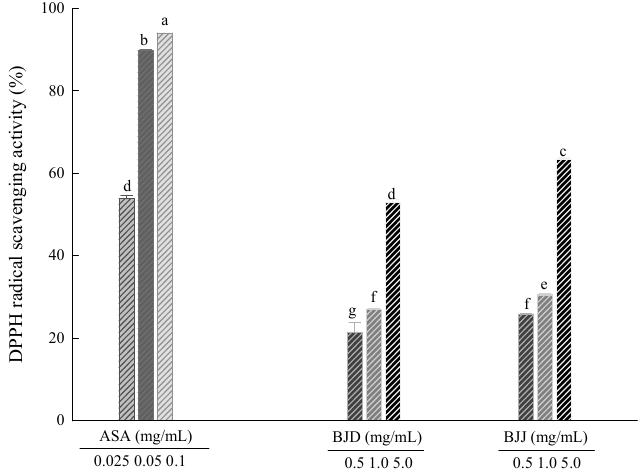
Figure 1. DPPH radical scavenging activity of BJJ and BJJ. Values are mean ± SD ( n = 3). Means (bar value) not sharing a common letter (a–g) are significantly different ( p < 0.05).